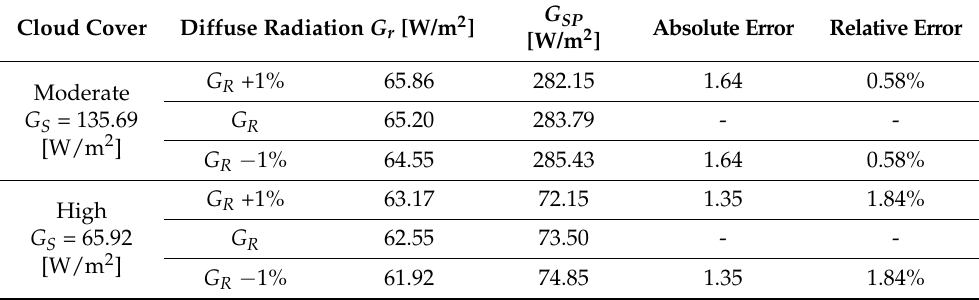
Table 1. Mean calculation errors for total radiation depending on mean diffuse radiation determination errors. Cloud